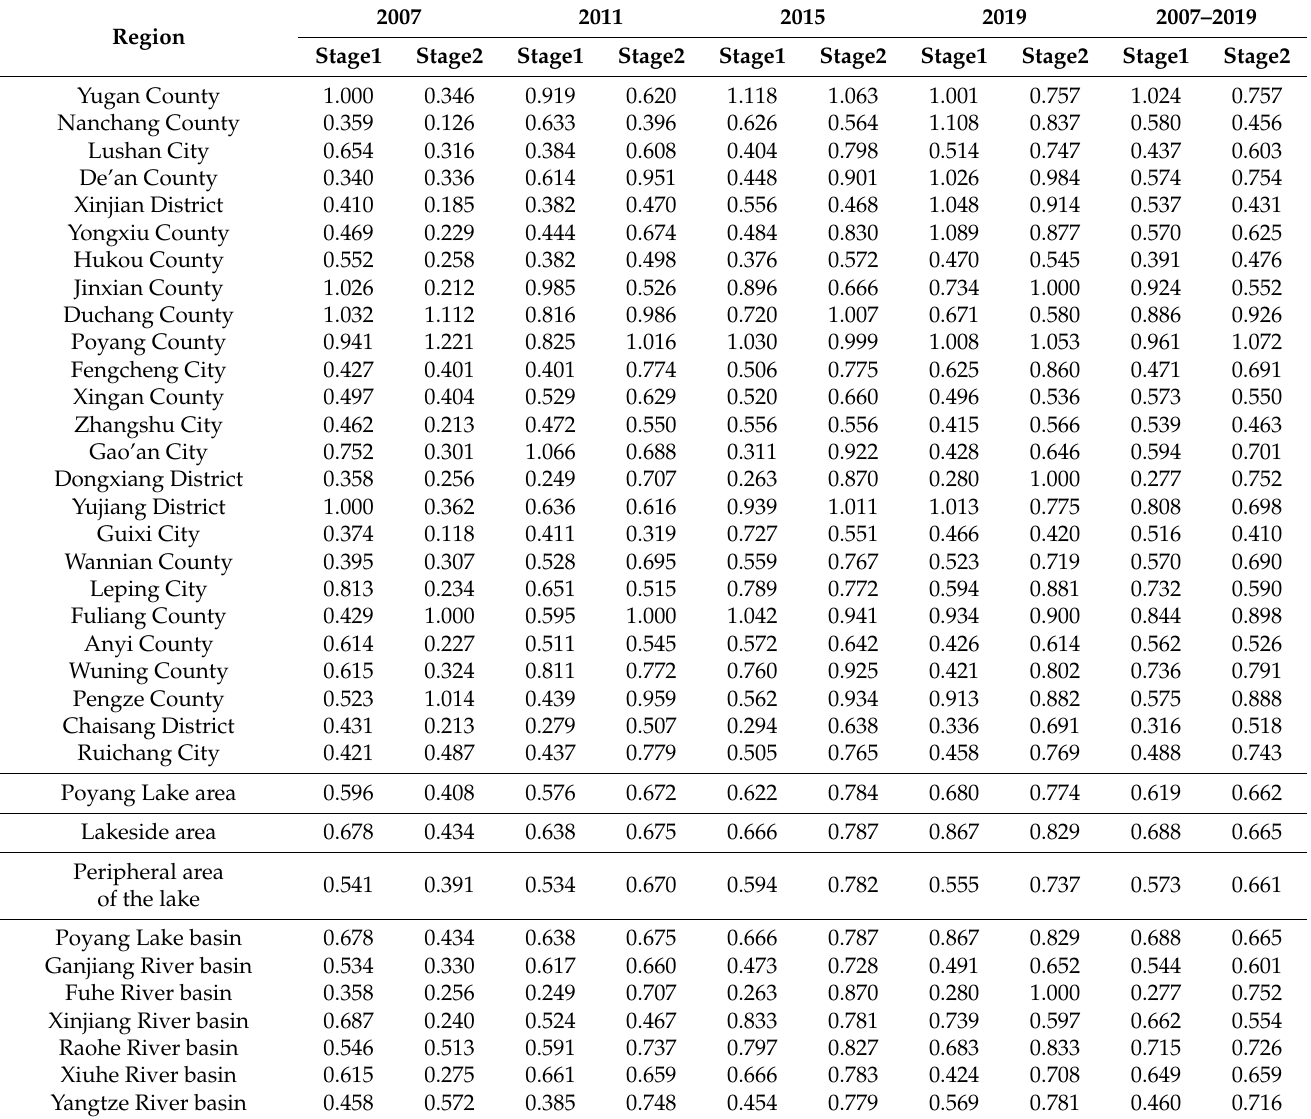
Table 3. Subphase efficiency of EWP in the Poyang Lake area from 2007 to